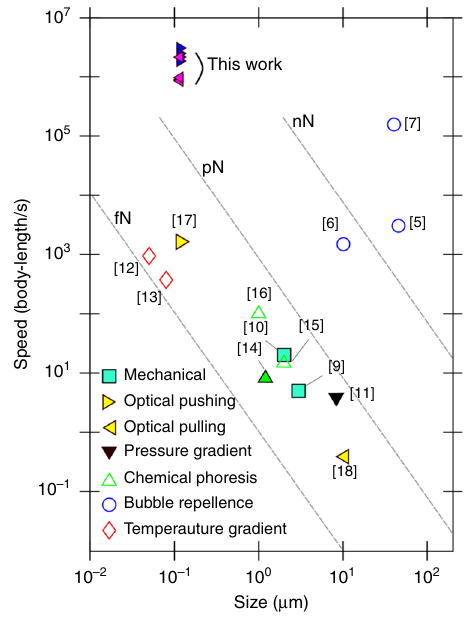
Fig. 4 Comparison of the ballistic Au NP swimmers with other swimmers. Top-four highest speeds (measured in body-length s − 1 ) for the nega- tive and the positive motion compared to those of the nanoswimmers/ microswimmers in the literature. The fi lled symbols represent nanoswim- mers/microswimmers whose movement can be directed. The hollow symbols represent those moving in random directions. The legend indi- cates propulsion mechanisms. The gray dash lines are contour lines of the magnitude of the force needed to achieve the corresponding speed of a swimmer in liquid